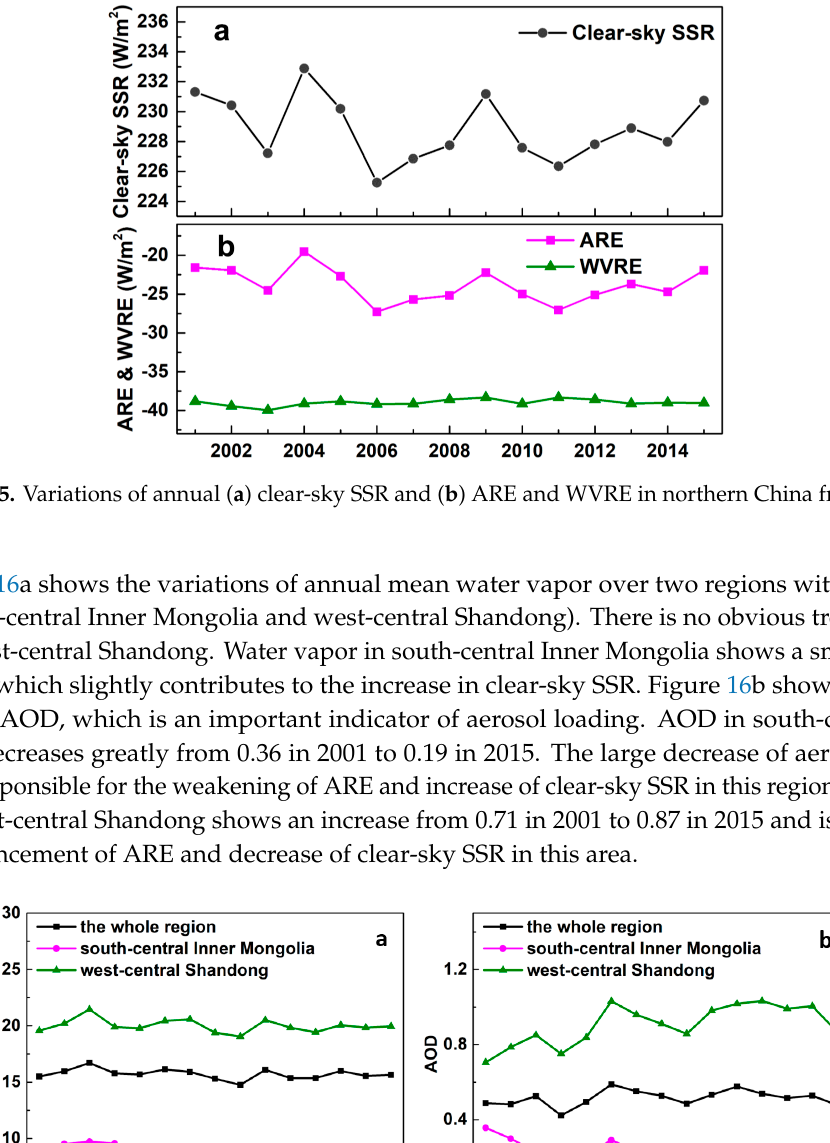
Figure 16. Variations of annual ( a ) water vapor and ( b ) AOD in south-central Inner Mongolia, west- central Shandong, and the whole study area from 2001 to 2015.